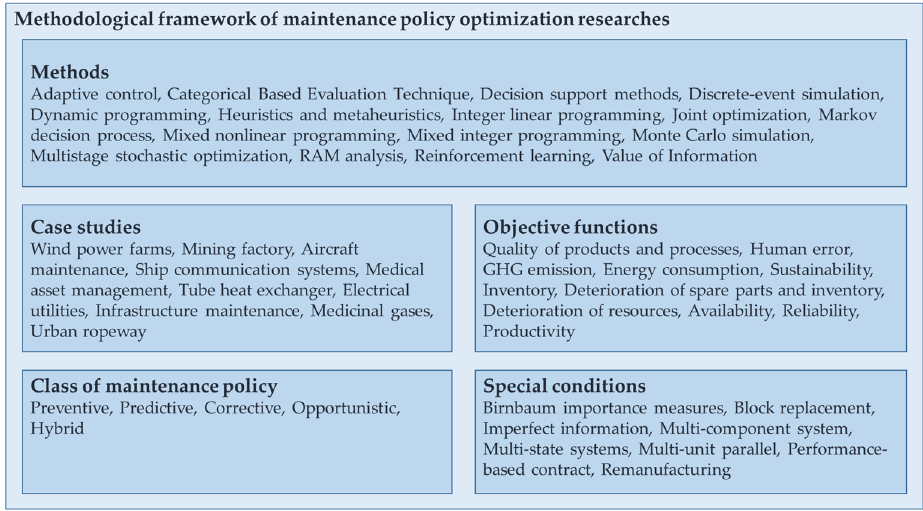
Figure 4. Methodological framework of maintenance policy optimization research based on the content analysis part of the systematic literature review.